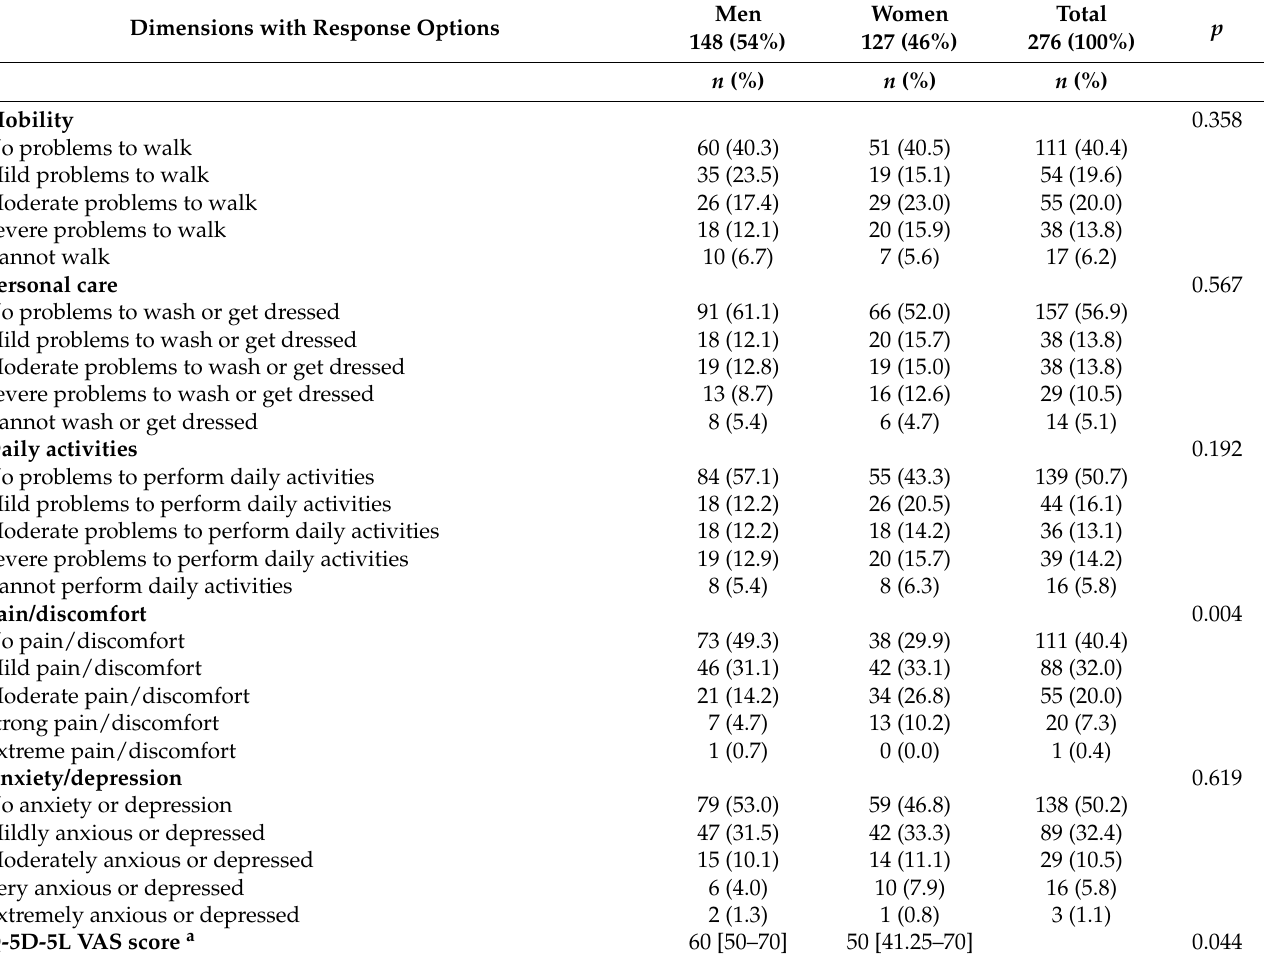
Table 3. Results of EQ-5D-5L questionnaire at